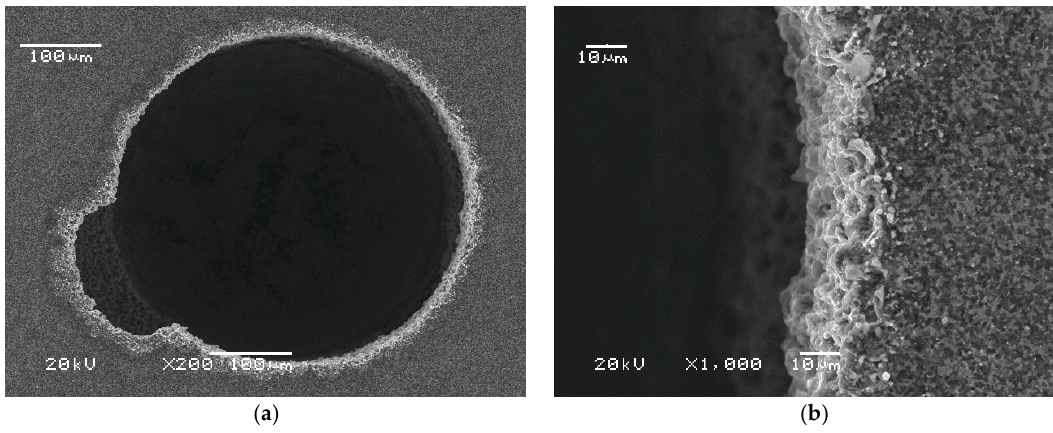
Figure 6. SEM images of hole no.1. U = 120V, t on = 10 μ s, t off = 10 μ s, threshold current I t = 0.3 A, working current I w = 0.9 A. ( a ) magnification 200×, ( b) magnification 1000×.